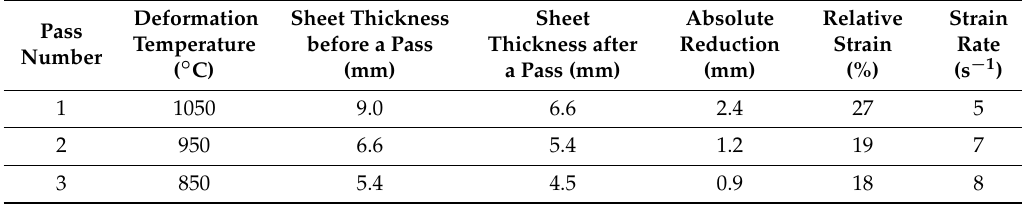
Figure 2. The macroscopic shape of samples used for interrupted tensile tests in respect of the microstructure and rolling and tensile directions.